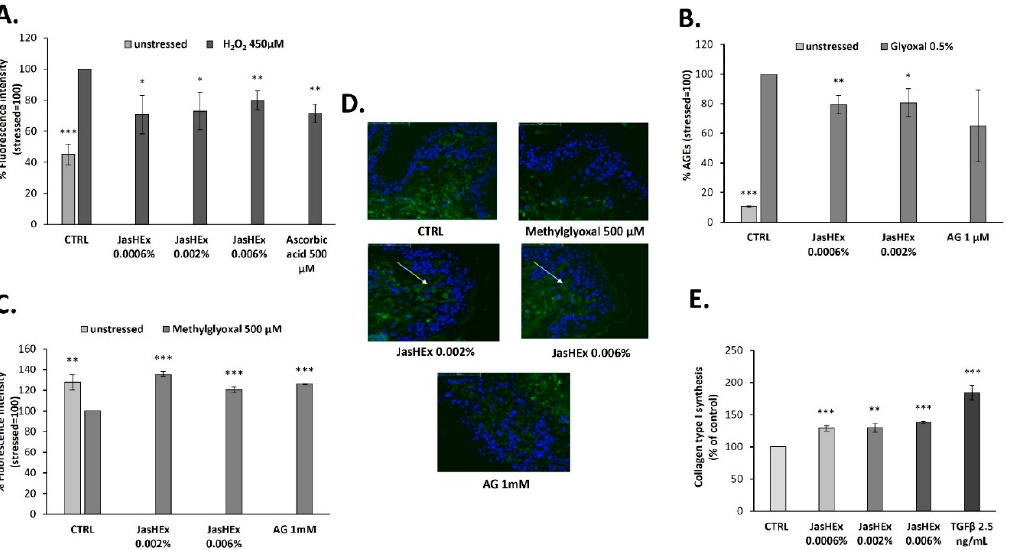
Figure 3. Bar graphs showing JasHEx ability ( A ) to decrease cytosolic ROS levels in H 2 O 2 -stressed HaCaT cells, ( B ) to inhibit AGE formation in glyoxal treated HDF and ( C ) to increment fibrillin-1 content in methylglyoxal stressed skin explants. Panel C has been obtained measuring the fluorescence intensity related to the photographs of skin sections ( D ) in which fibrillin-1 has been highlighted with a specific antibody labeled with fluorophore (green) and the nuclei (blue) have been stained with 4 ′ ,6-diamidine-2-phenylindole (Dapi). Panel E shows the increase of collagen type I synthesis. The bars represent the standard deviations and the asterisks indicate significant variations according to Student’s t-test (* p < 0.05, ** p < 0.01, *** p < 0.001).